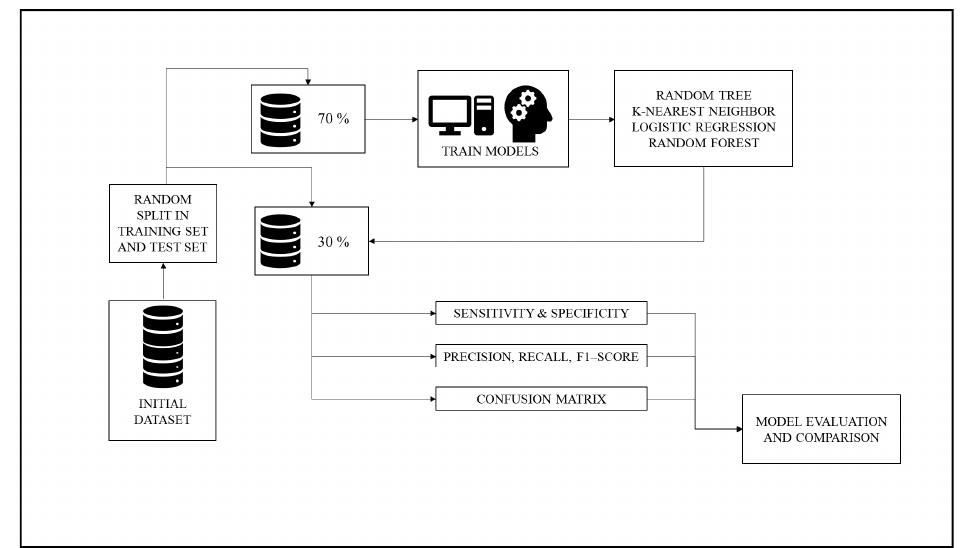
Figure 1. The workflow of the first phase.